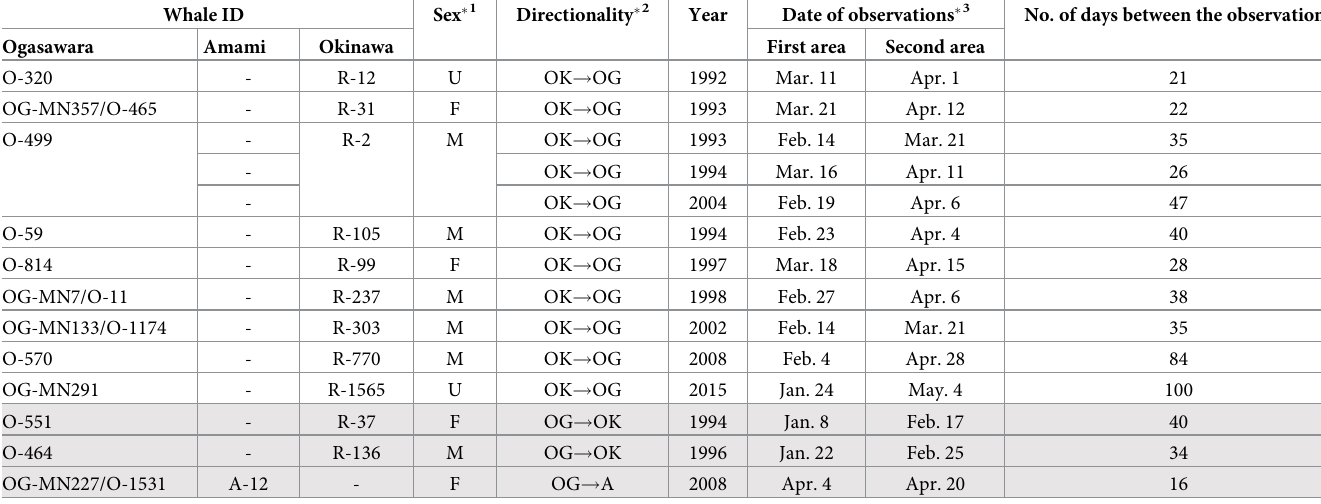
females, and two of unknown sex) were observed at both Ogasawara and Okinawa in the same season (Tables 5 and 6). Meanwhile, 100 cases with 88 unique individuals (29 males, 12 females, and 47 of unknown sex) were observed both in Amami and Okinawa in the same year (Table 5). Multiple within-season movements between several areas by the same individuals were only documented between Amami and Okinawa in this study for eight cases with eight unique individuals (i.e., two males, one female, and five of unknown sex; Tables 5 and 7). Overall, within the 100 matched individuals that were observed in two different regions among three of the areas within the same season, males were observed more than twice than the females, except for the case between Ogasawara and Amami where only one female was observed in both areas in the same season (Table 5). Among the whales that moved between different regions within the same season, the dura- tion of travel between the regions varied. Within-season movement between Ogasawara and Table 6. Details of whales observed between Ogasawara, Amami, and Okinawa within the same season. The lines in gray are the westward movements from Ogasa- wara to Amami/Okinawa, while others are eastward movements from Amami/Okinawa to Ogasawara. Whale ID